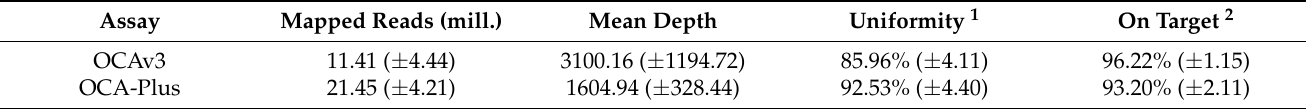
Table 3. Quality measurements of sequencing reactions.